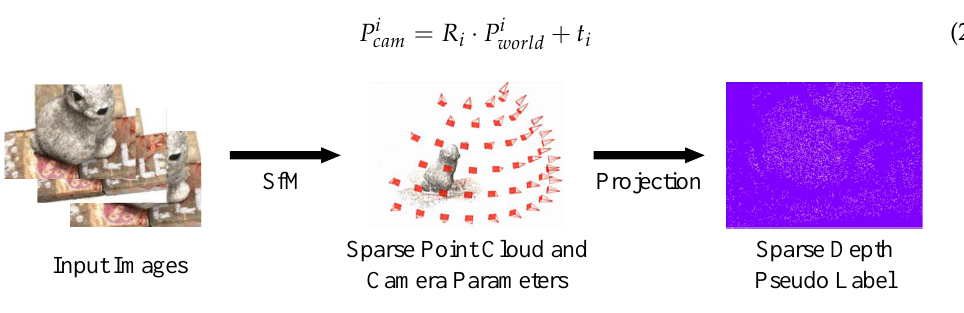
Figure 3. Generation of sparse